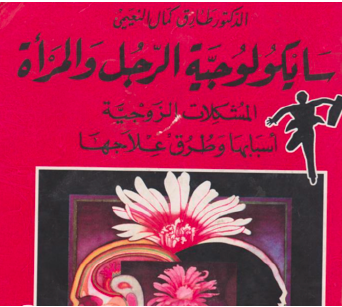
Figure 1. A sample frontispiece with multiple Arab